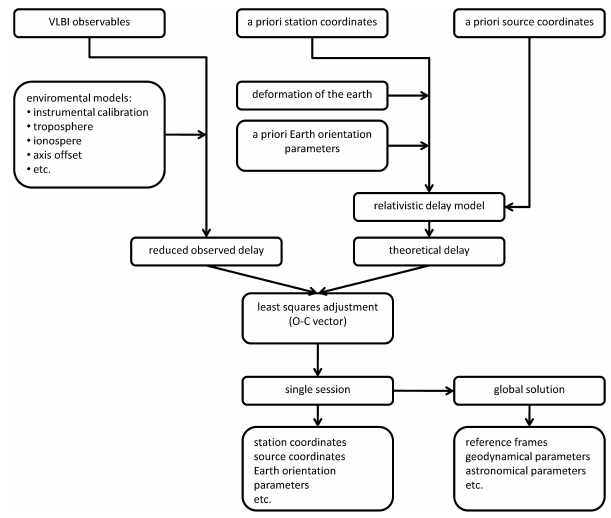
Fig. 4. Flow chart of VLBI analysis model (modified from Schuh and Böhm, 2013).